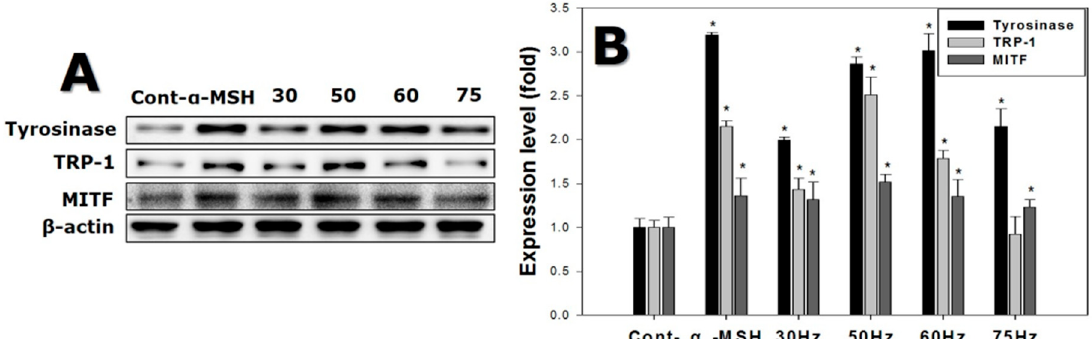
Figure 8. Western blot of protein expression levels detected in melanocytes after exposure to extremely low frequency electromagnetic fields for 72 h. ( A ) Melanogenesis-related protein banding, using β -actin as an internal control; ( B ) Melanogenesis-related protein expression. Each bar represents the mean ± standard error of independent experiments performed in triplicate ( n = 5). * p < 0.05, compared to the control (Cont).